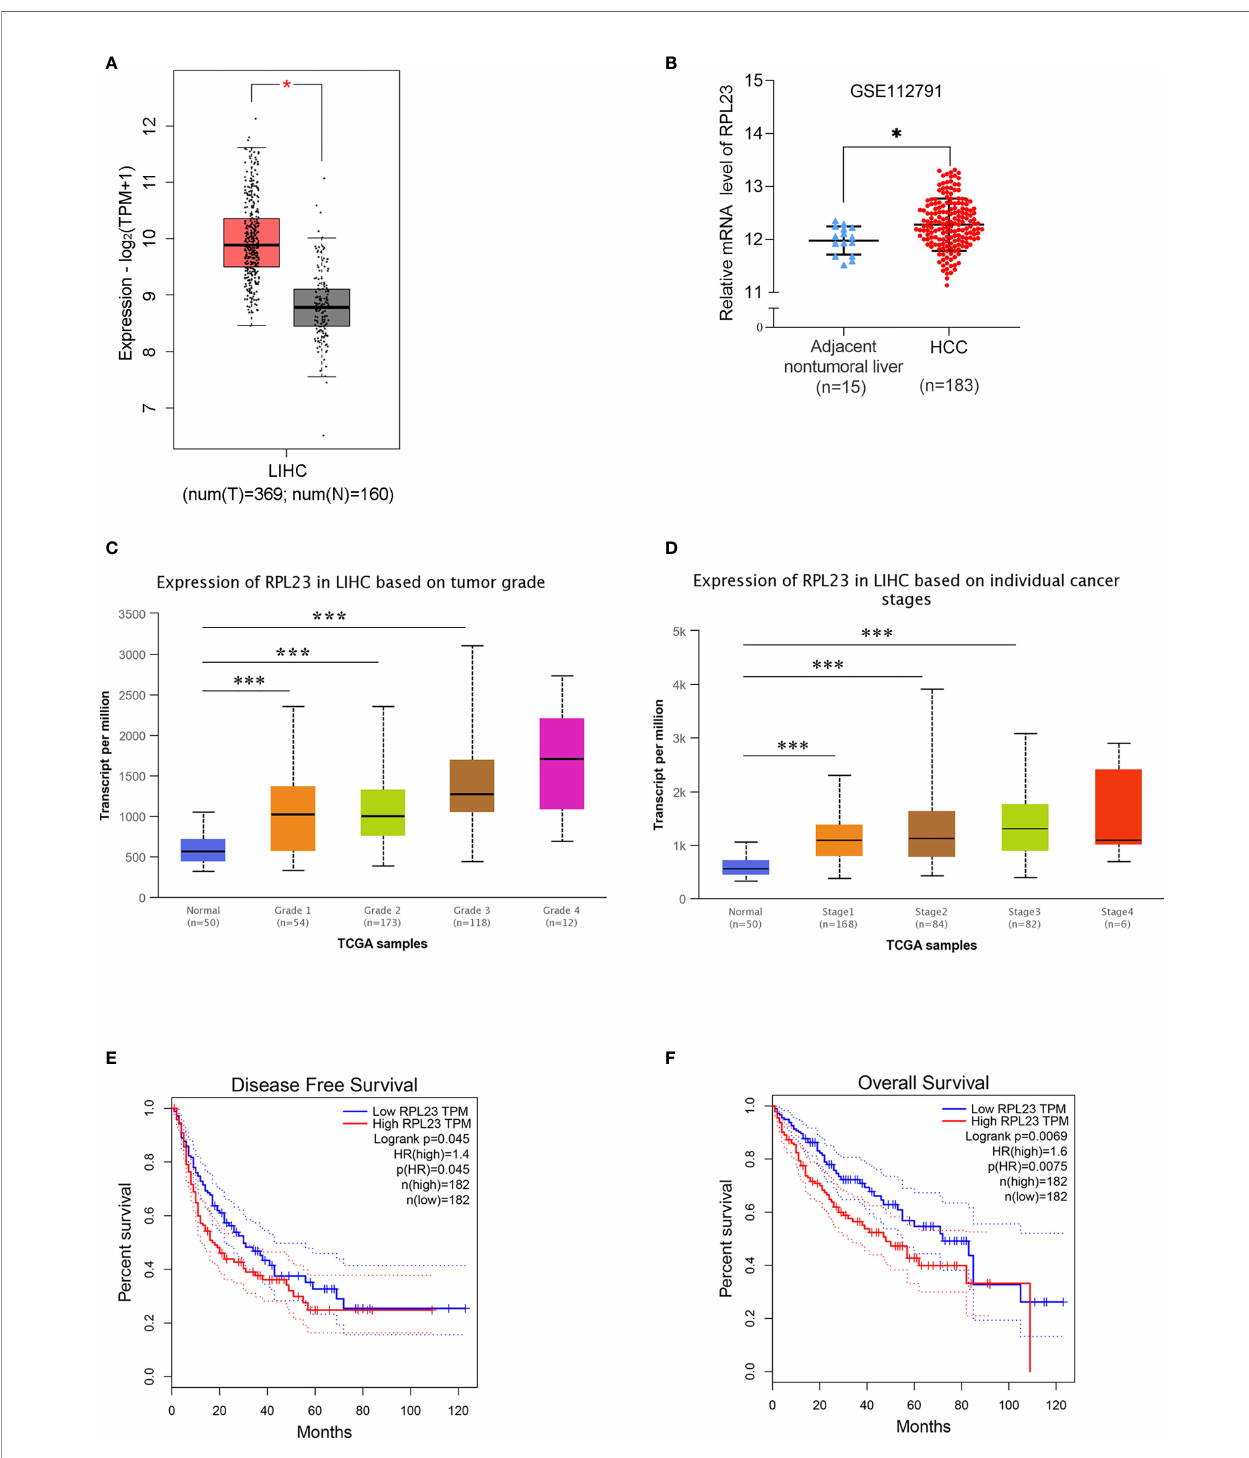
FIGURE 1 | RPL23 overexpression and clinical pathological analysis in HCC tissues according to different public databases. (A) The mRNA level of RPL23 in the adjacent nontumor liver tissues (n=160) and primary liver tumor tissues (n=369) revealed by transcriptome sequencing of TCGA. (B) The mRNA level of RPL23 from RNA-sequencing data on 183 primary human HCC tissues and 15 adjacent nontumor liver tissues of GEO database in the GSE112791 cohort. (C) RPL23 overexpression in HCC based on tumor grade in Ualcan data-mining platform (http://ualcan.path.uab.edu/index.html). (D) RPL23 expression in HCC based on tumor stage. (E) Correlation between RPL23 expression and disease-free survival in TCGA HCC cohort. (F) OS curve of HCC patients based on RPL23 expression in TCGA HCC cohort. *p < 0.05, ***P <